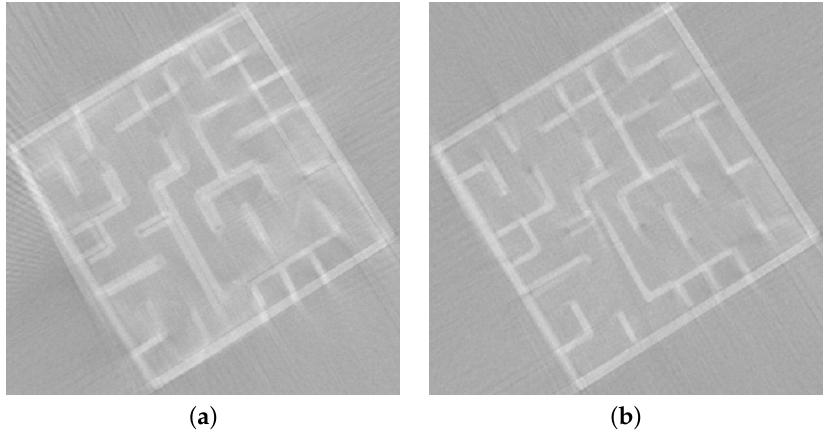
Figure 8. Slices of the reconstructed model at Td y = 38.1093 mm: ( a ) Reconstruction based on the rotation axis invariance method; ( b ) Reconstruction based on the proposed